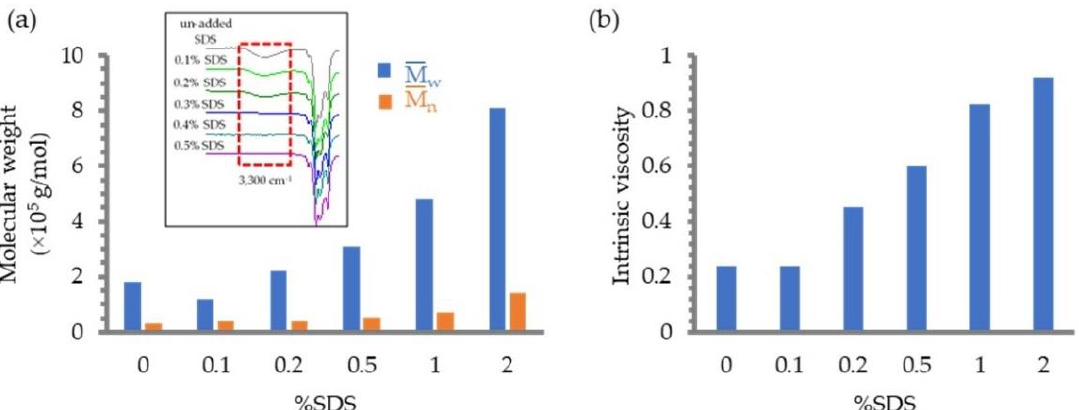
Figure 7. Effect of the surfactant concentrations on ( a ) the MW and the change of FT-IR spectra and ( b ) intrinsic viscosity of DPNR after the reaction in the presence of H 2 O 2 and TiO 2 film irradiated with UV light for 5 h.